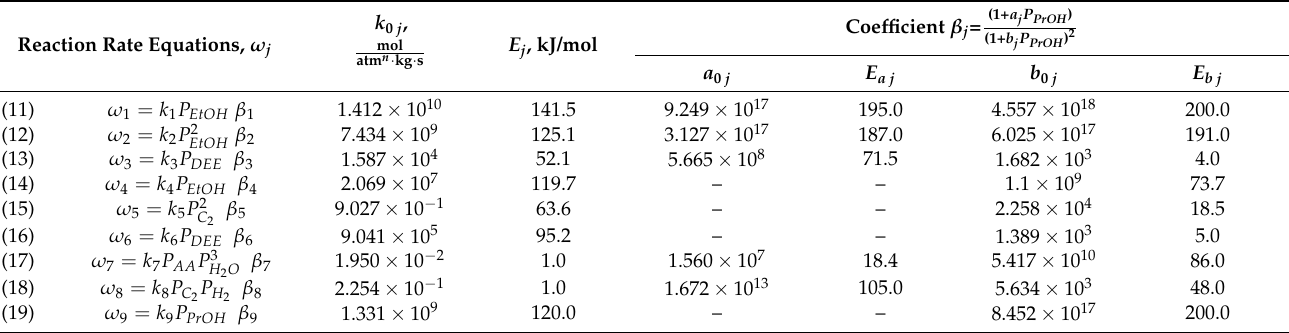
Table 1. Kinetic model and its